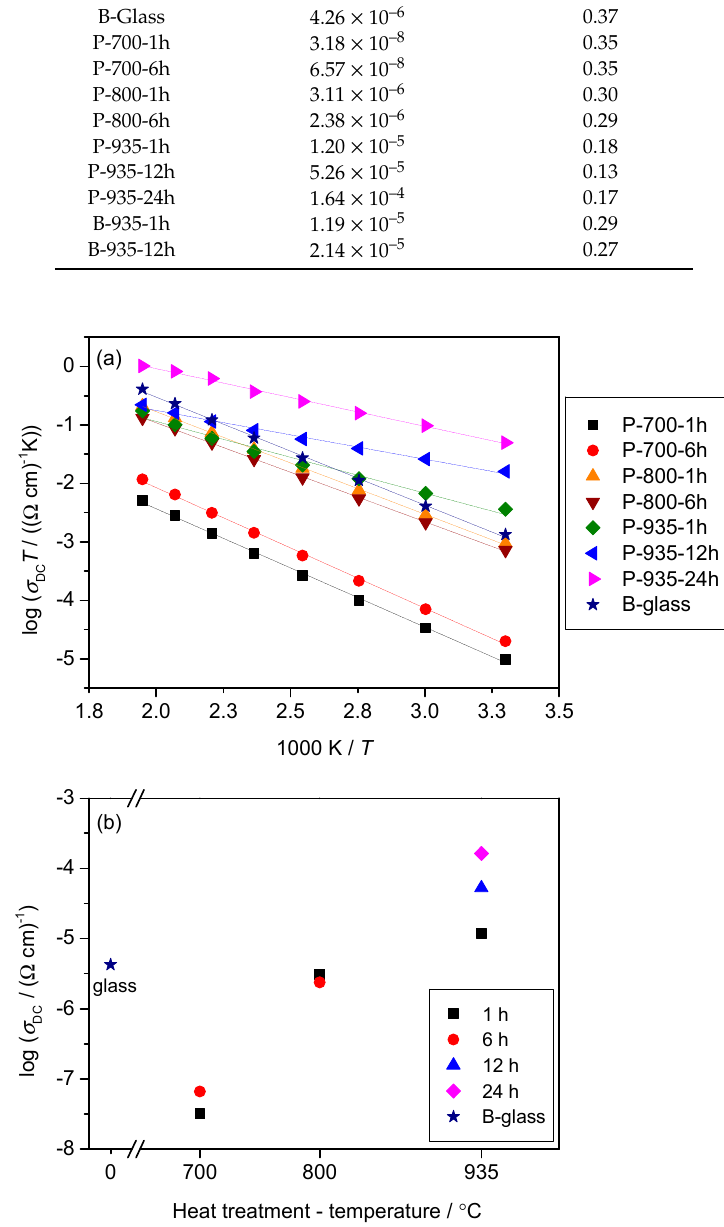
Figure 5. ( a ) Arrhenius plot of the parent 60WO 3 -40P 2 O 5 glass and glass-ceramics prepared from pellets and ( b ) their DC conductivity, σ DC , at 30 °C as a function of crystallization temperature and time. The error bars are at most of the order of the symbol size.